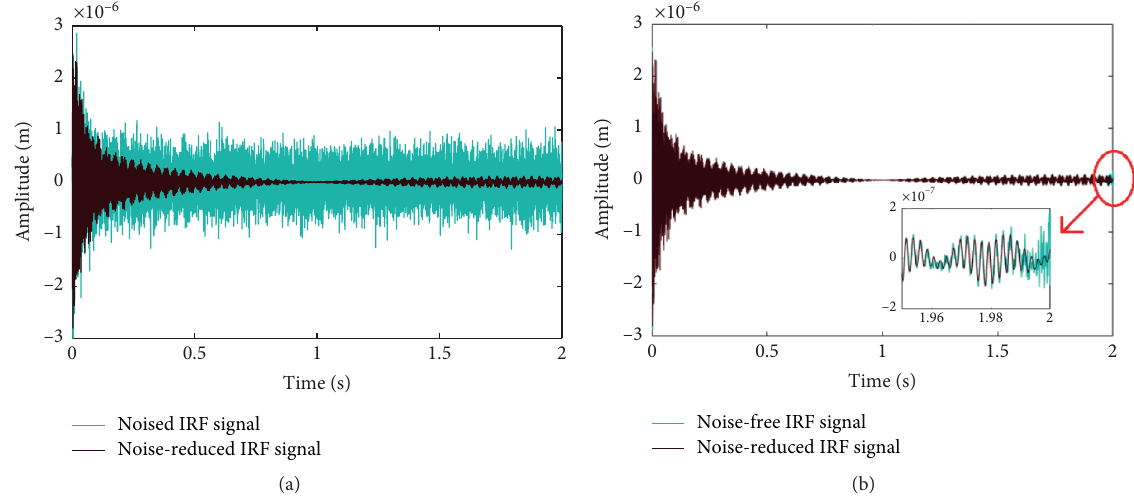
Figure 6: (a) Overlay of the noised IRF signal. (b) Overlay of the noise-free IRF signal.